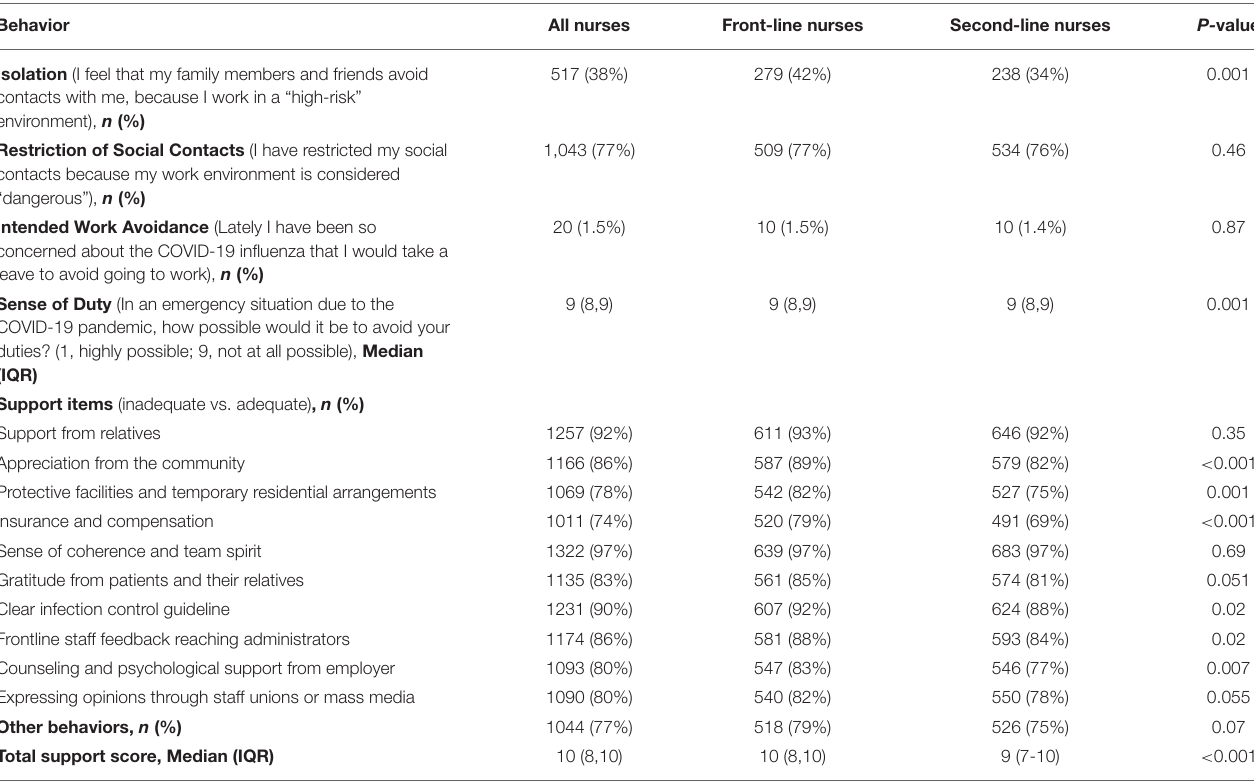
TABLE 6 | Presence of anxiety-producing behavior and social support among 1,364 Chinese nurses during the COVID-19 pandemic. Behavior All nurses Front-line nurses Second-line nurses P- value